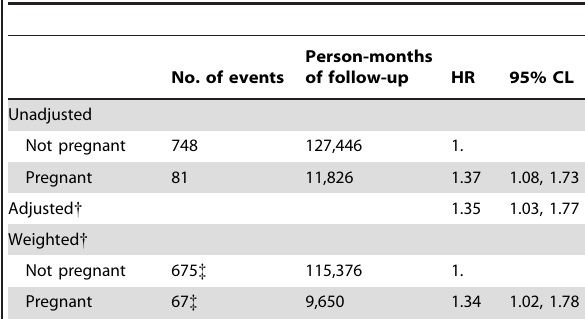
Table 2. Estimated effect of incident pregnancy on time to virologic failure among 5,494 women initiating HAART in South Africa, 2004–2009.